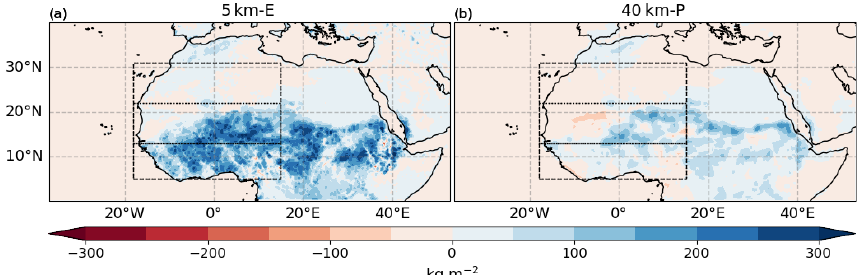
Figure 11. Difference of the JAS mean soil moisture content in the six uppermost soil layers between the GS-cSM and the GS simulation for the 5km-E (a) and the 40km-P (b) simulations. The dashed black box indicates the WA analysis domain.